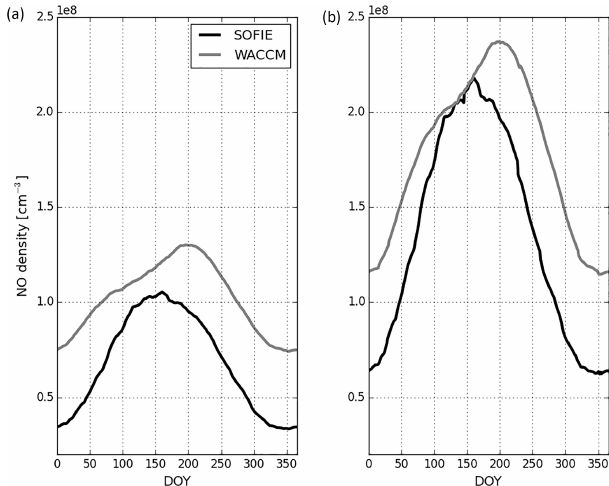
Figure 4. (a) Mean column density of NO in the lower thermo- sphere region from 90 to 140km. (b) Mean column density in the 10km bin centred around the altitude of maximum NO.